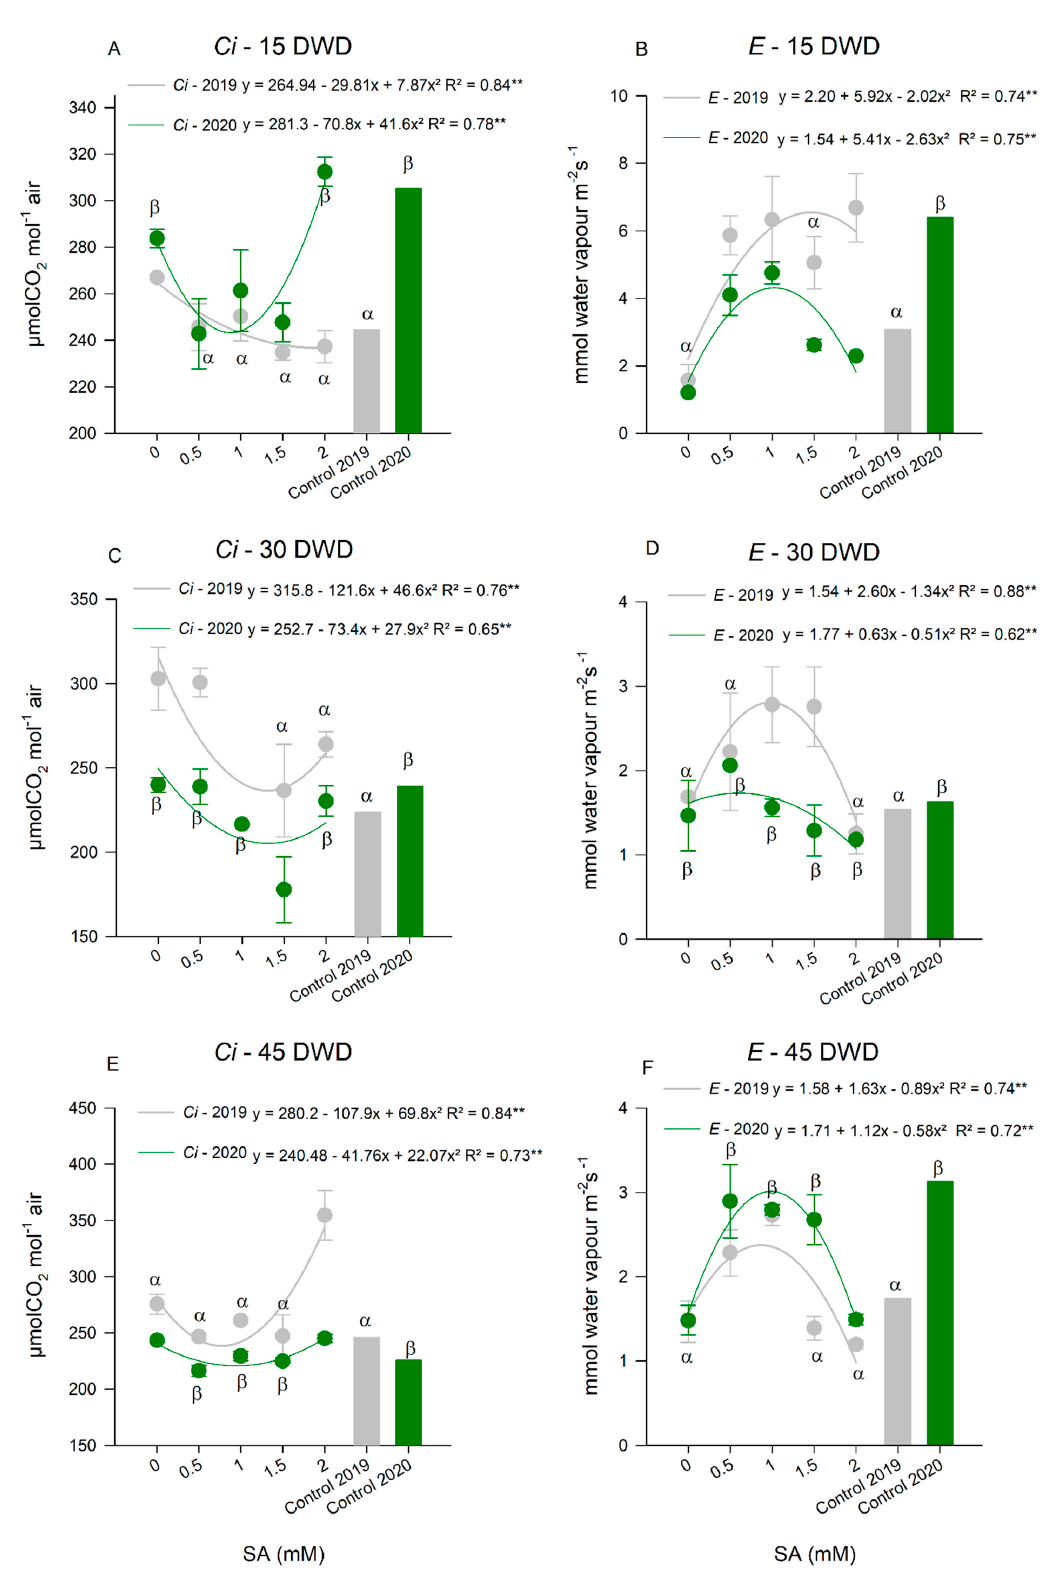
Figure 3. Internal concentration of CO 2 (Ci) at 15 ( A ), 30 ( C ), and 45 ( E ) days of water deficit (DWD); transpiration ( E ) at 15 ( B ), 30 ( D ), and 45 ( F ) DWD of tomato plants subjected to application of salicylic acid (SA) doses in two consecutive years 2019 and 2020. ** Highly Significant at 5% probability; α Indicates that there was an equal and significant effect between treatments by the Dunnett’s Test at 5% probability in the 2019 cycle and β in the 2020 cycle. The bars show the standard deviation. n = 4 (number of